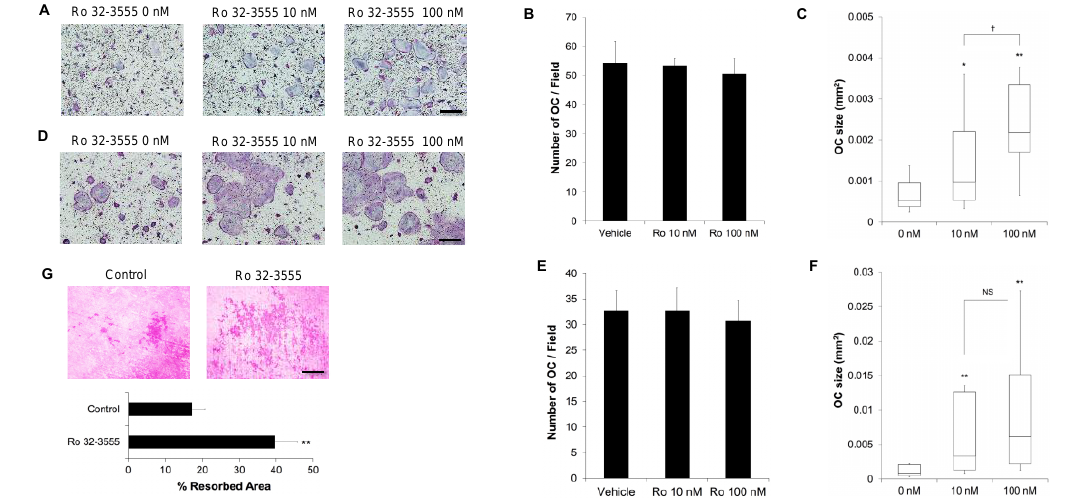
Figure 2. The effect of collagenase inhibition on osteoclast size. ( A ) BMMs were cultured with M-CSF and RANKL for 5 days in the presence of a collagenase inhibitor Ro 32-3555. Osteoclasts were stained for TRAP activities. ( B ) The number of osteoclasts was counted from the experiments in ( A ). ( C ) The size of osteoclasts was measured form the experiments in ( A ). ( D ) BMMs were co-cultured with calvarial cells for 7 days in the presence of vitamin D 3 and PGE 2 to induce osteoclast differentiation. Cells were stained for TRAP activities. ( E ) The number of osteoclasts was counted from the experiments in ( D ). ( F ) The osteoclast size was measured from the experiments in ( D ). ( G ) BMMs were cultured on dentin discs for 7 days with M-CSF and RANKL in the presence or absence of 100 nM Ro 32-3555. The resorption pits were stained with hematoxylin. Data are mean ± SD of triplicate experiments representative of three independent experiments. *, p < 0.05. **, p < 0.01 against control. †, p < 0.05 between two concentrations. Scale bars indicate 100 μm.